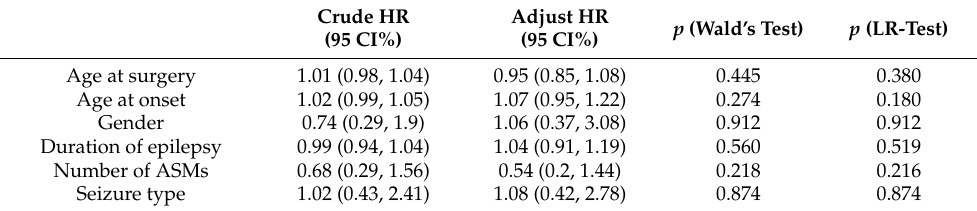
Figure 3. Multivariate regression analysis showing the independent prognostic factors of DRE. Table 5. Adjust hazard ratio and C-index of the multivariate Cox regression.